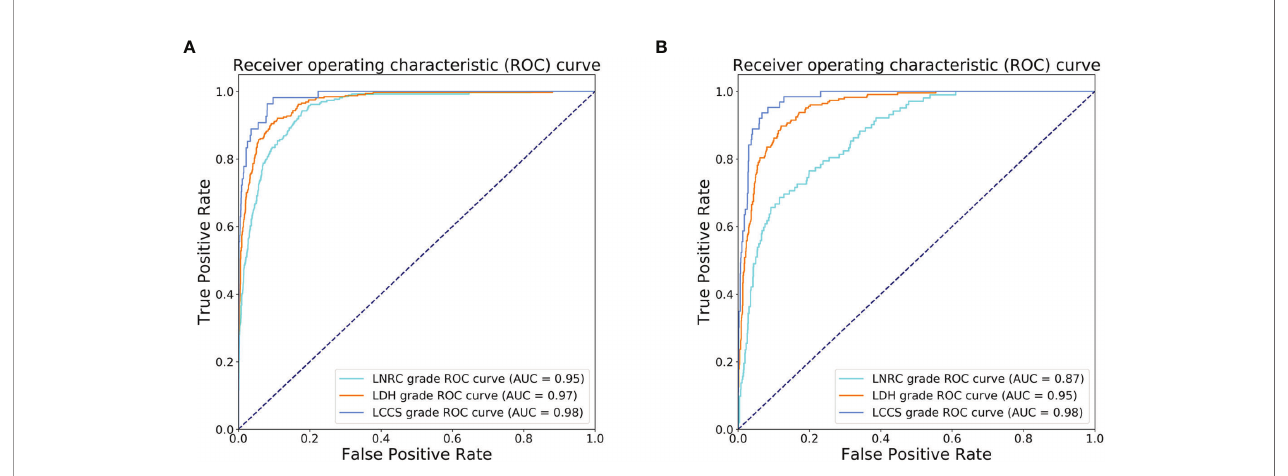
FIGURE 8 | Receiver operating characteristic (ROC) curves of dichotomous grading (grade 0 or grade 1 vs. grade 2 or grade 3) for the three spine diseases. (A) ROC curves for the automated grading of three diseases: lumbar disc herniation (LDH), lumbar central canal stenosis (LCCS) and lumbar nerve roots compression (LNRC) on the internal test dataset. (B) ROC curves for the automated grading of three diseases: LDH, LCCS and LNRC on the external test dataset.